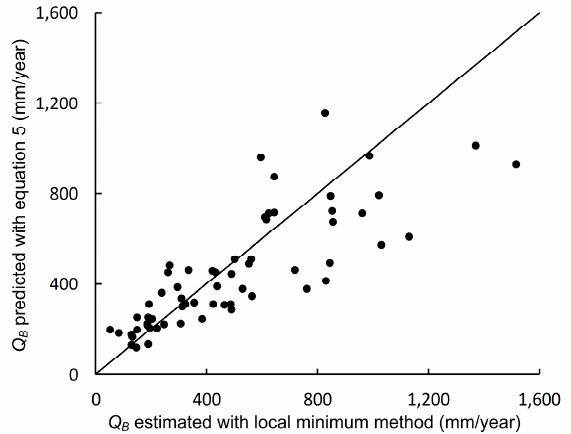
Figure 7. Comparison of observed ( Q B estim j ) and predicted (Q B pred j ) specific median annual baseflow in each gauged catchment j .